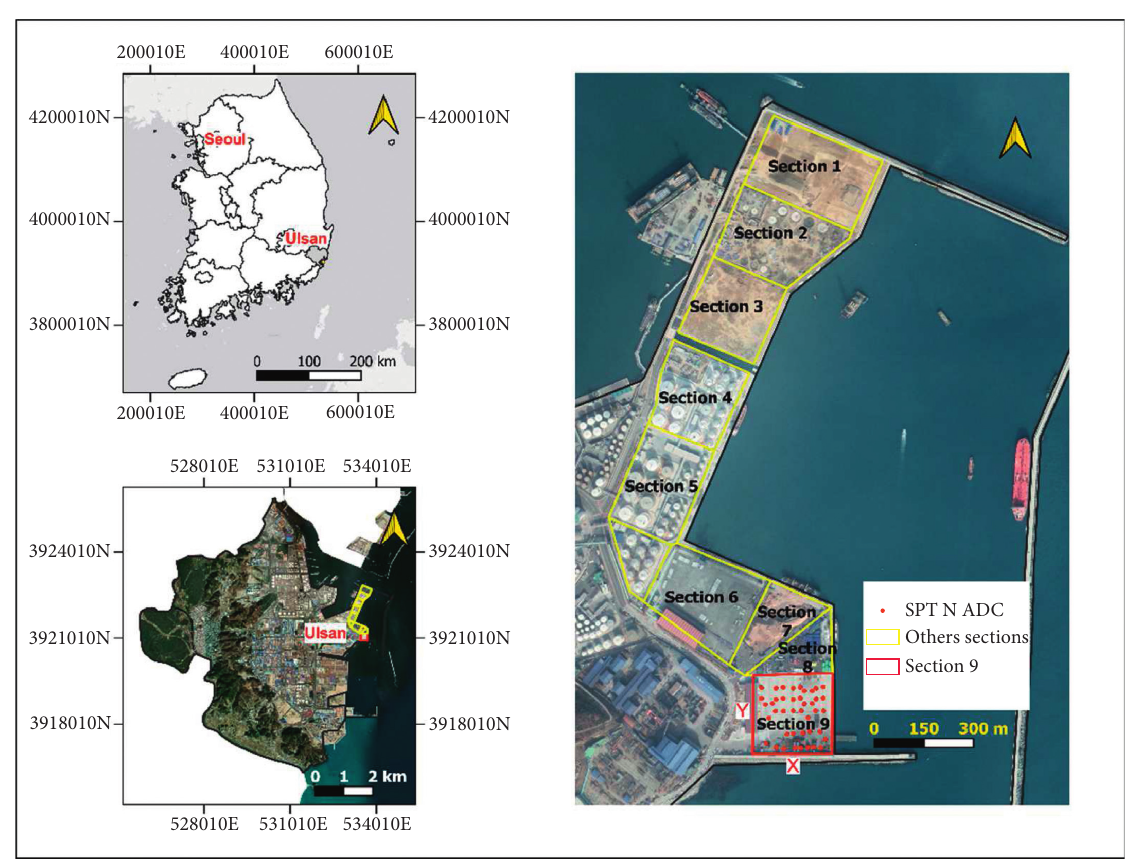
Figure 1: The study area (QGIS integrated with a historical map from Google Earth): site location map for the dynamic compaction (DC) project. X and Y indicate the coordinates for the study area where SPT-N ADC is the borehole location after dynamic compaction